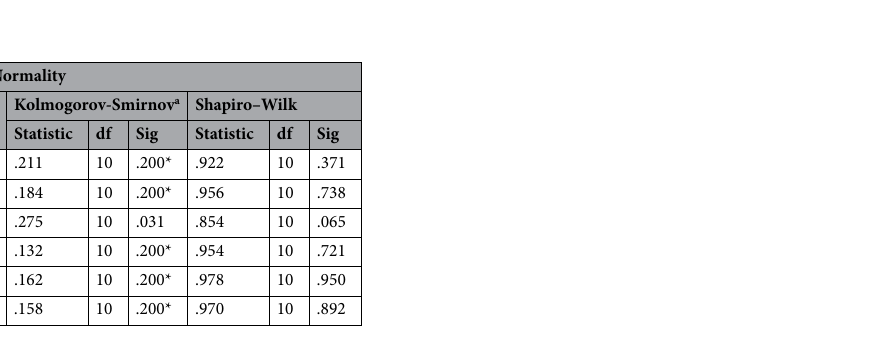
Table 2. Illustrates normal distribution of the variables. COM; Centre of Mass. ROT; Rotational